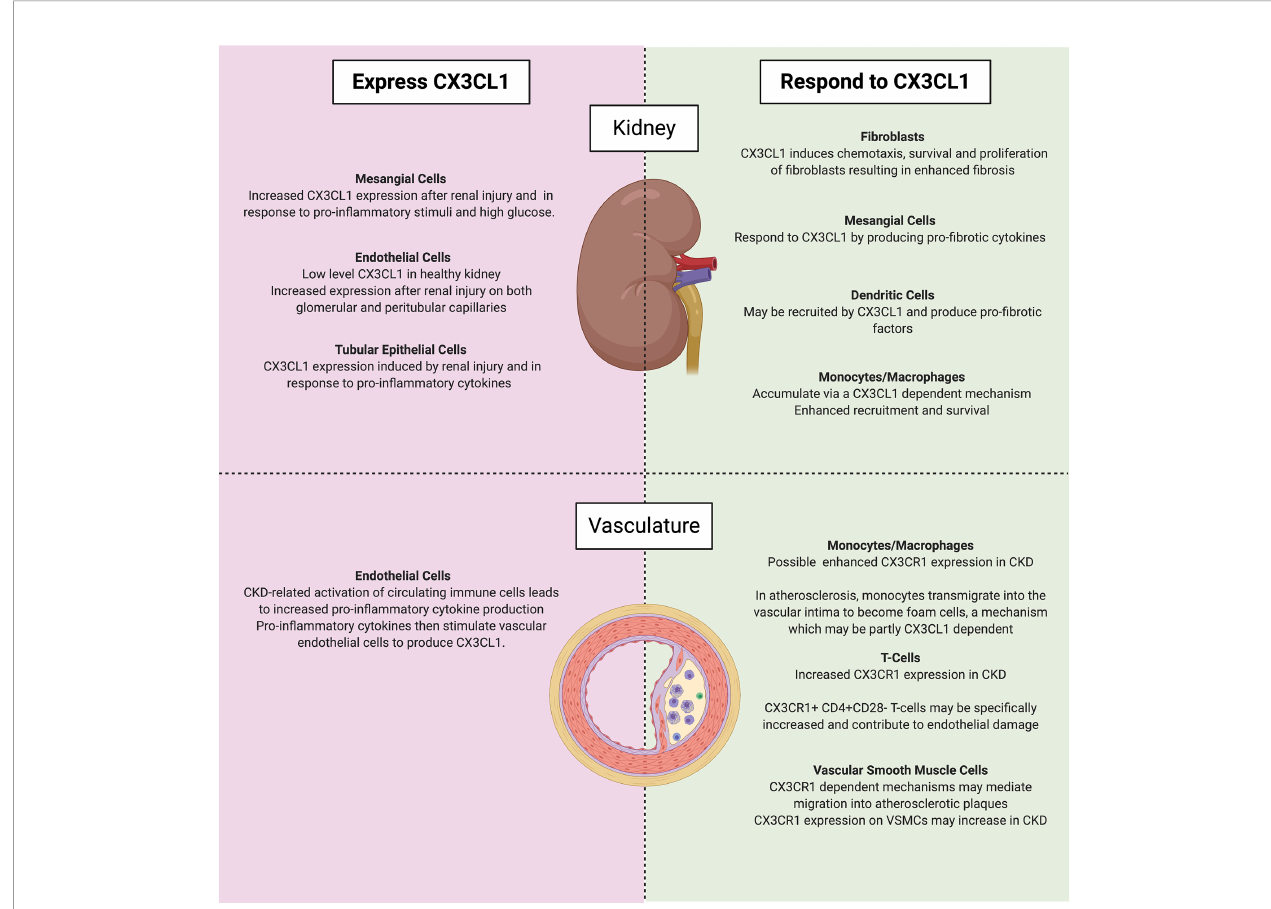
FIGURE 2 | Cell types which either express (left) or respond to (right) CX3CL1 in CKD within the kidney (top) and vasculature (bottom). Of note, mesangial cells may both express and respond to CX3CL1. Created with